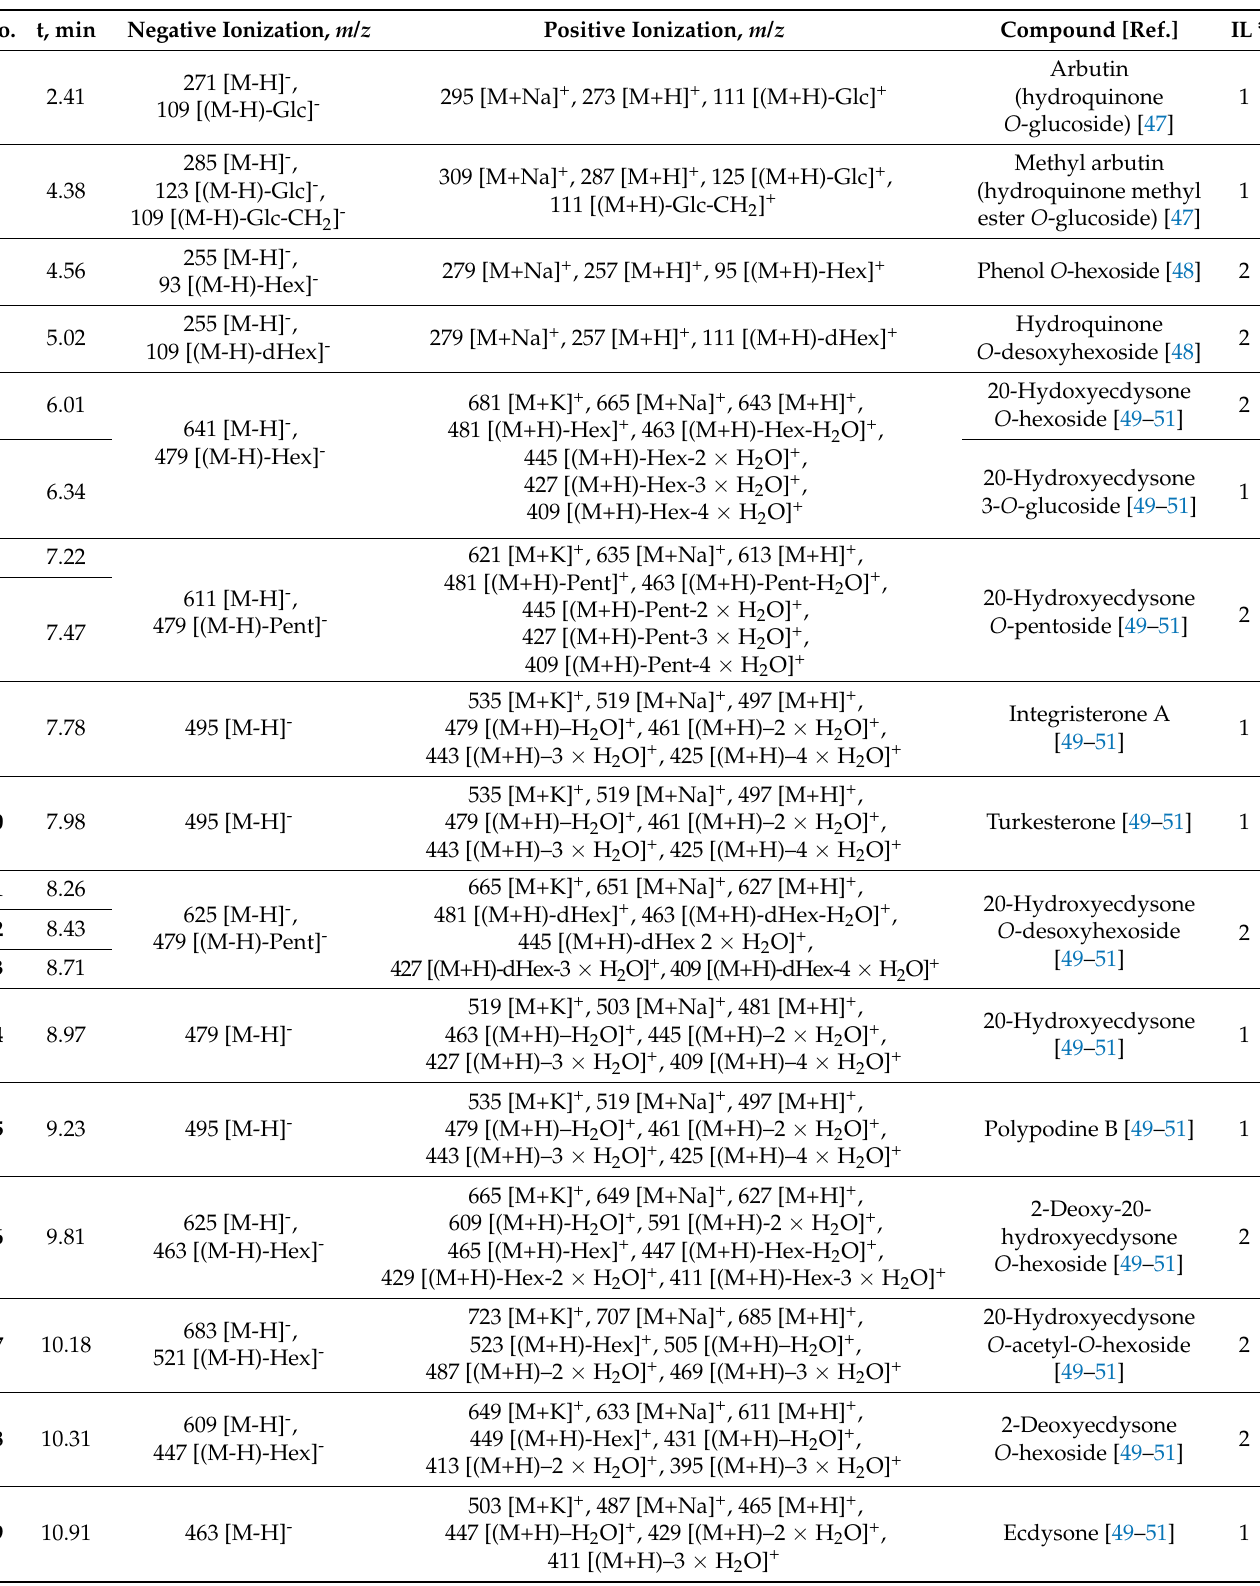
Table 1. Chromatographic (t) and mass-spectrometric data of compounds 1 – 41 found in K. centauroides leaf